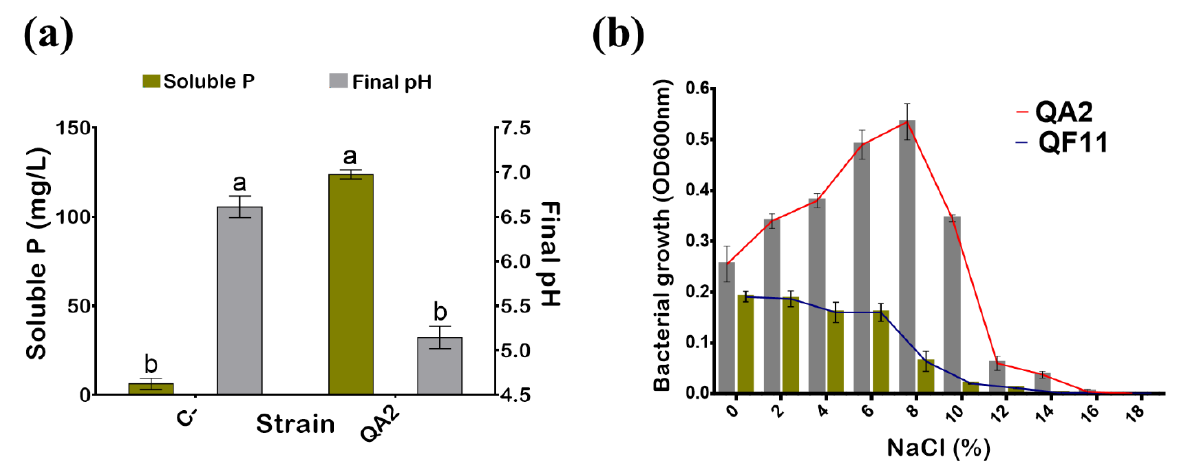
Figure 1. ( a ) Phosphate solubilization by the QA2 isolate in presence of 0.5% TCP in NBRIP broth and final pH of media. Uninoculated NBRIP media were used as negative control (C − ). ( b ) Effect of NaCl on QA2 growth in TSB broth after 48 h of incubation. The experiment was carried out in triplicate (n = 3). Enterobacter asburiae QF11 was used as PGPR reference strain. Letters in superscript indicate the significant difference at 95% between treatments. Table 2. Summary of some morphological, physiological, and biochemical characters of the QA2 isolate using plate